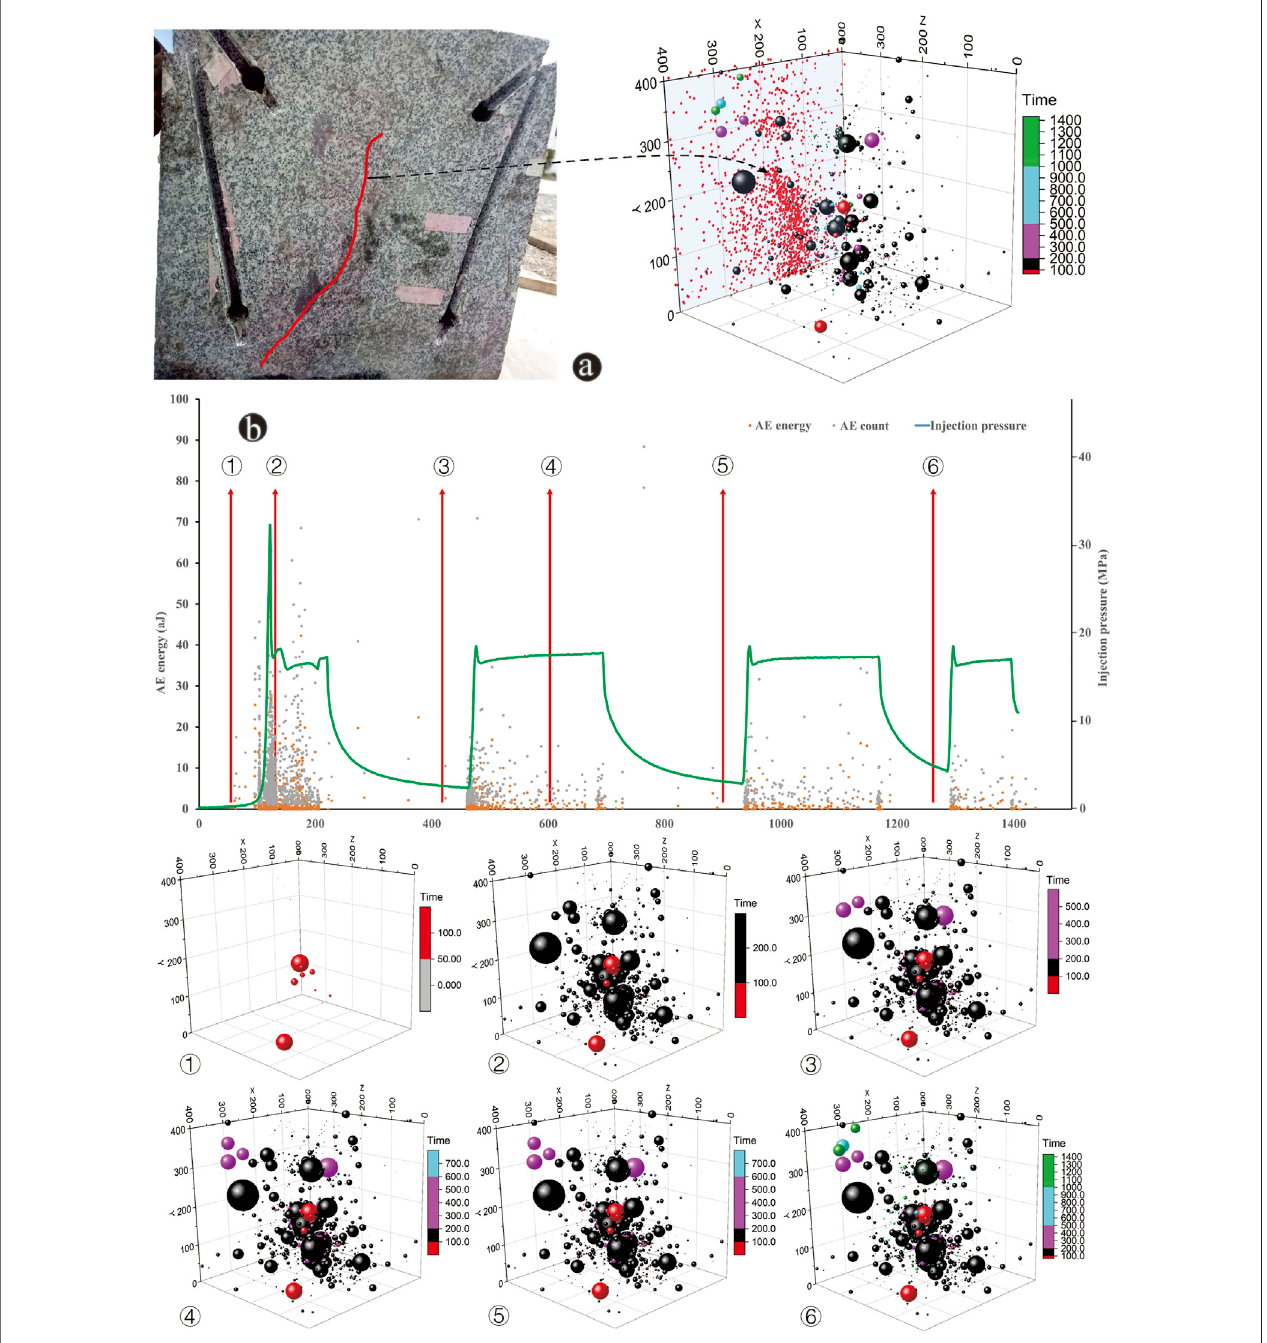
FIGURE 8 | AE spatial distribution characteristics of HDR400-2 (A) AE spatial distribution compared with the surface appearance of the sample; (B) AE spatial distribution of each pump period. ① – ⑥ represent the spatial distribution characteristics of AE for different section of the pressure curve corresponding to the time increasing. See Figure 7 for detailed fi gure